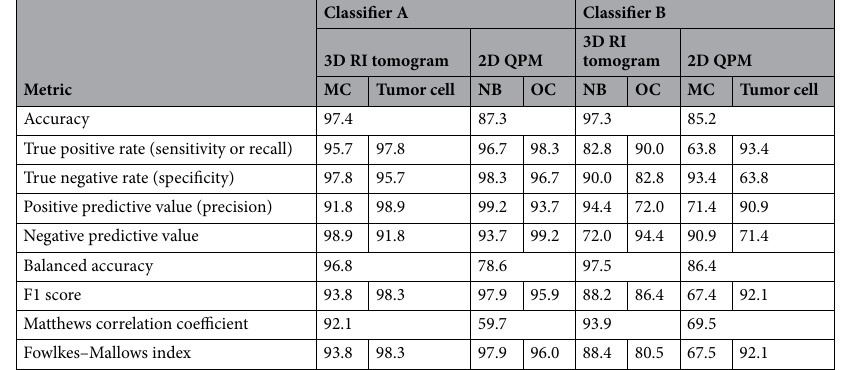
Table 1. Performance of the classifier A (shallow neural network in the case of 3D RI tomograms and logistic regression in the case of 2D QPMs) and the classifier B (shallow neural network in the case of 3D RI tomograms and linear discriminant in the case of 2D QPMs) over the test set.